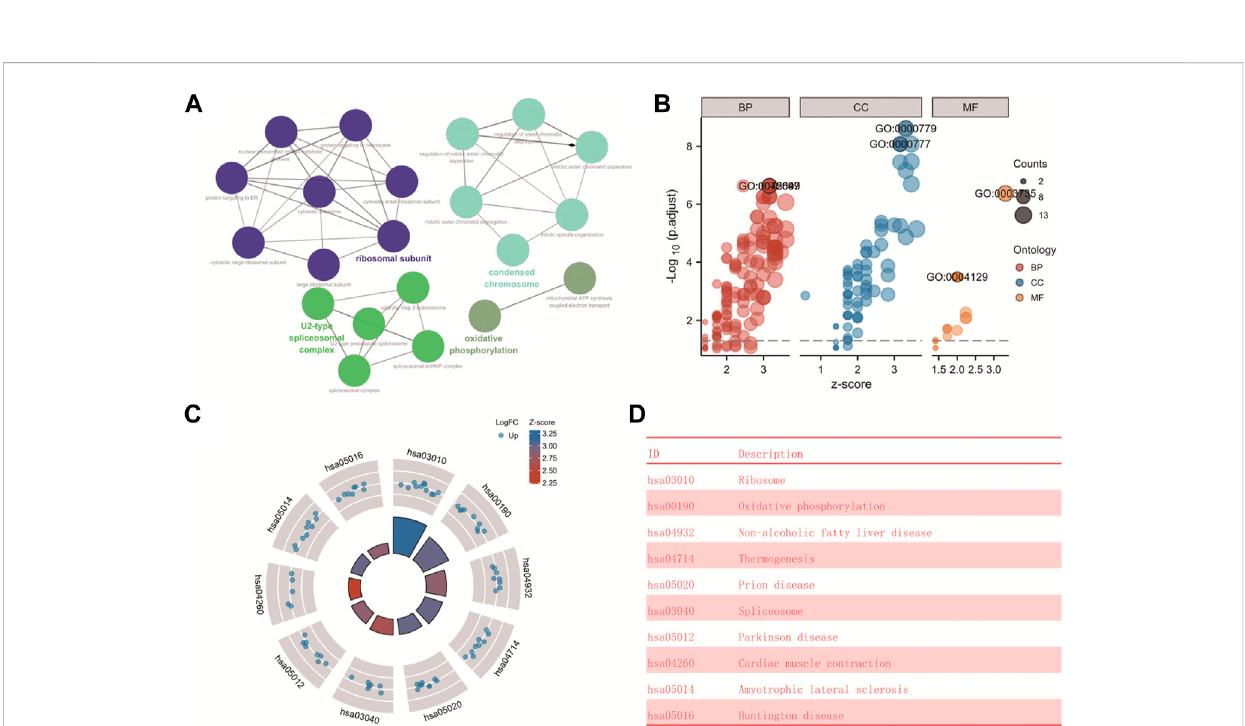
FIGURE 3 Geneontology(GO)andkyotoencyclopediaofGenes(KEGG)enrichmentanalysesofDEGs. (A) GOenrichmentanalysis.Zsoreispositive,indicating thatthecorrespondingitemmaybeapositiveadjustment.Zsoreisnegative,indicatingthatthecorrespondingitemmaybeanegativeadjustment. (B) The graph corresponding to fi gure (A,C) Zsore is positive, indicating that the corresponding item may be a positive adjustment. Zsore is negative, indicating that the corresponding item may be a negative adjustment. (D) The graph corresponding to fi gure (C)